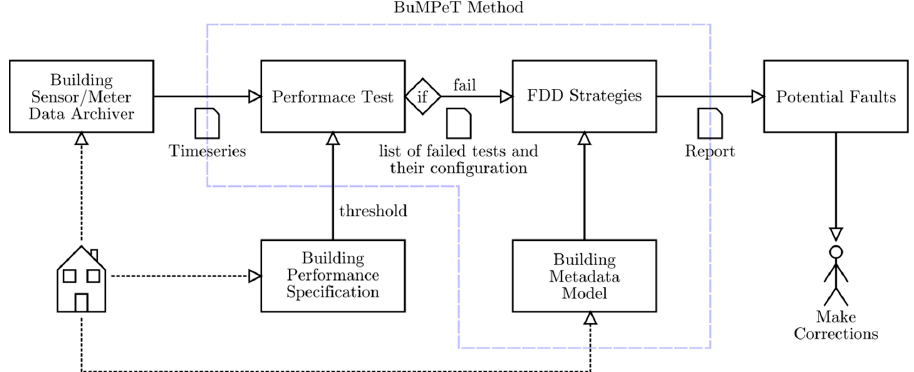
Figure 1. Overview of the Building Metadata Performance Testing (BuMPeT) method. FDD: fault detection and diagnostics.